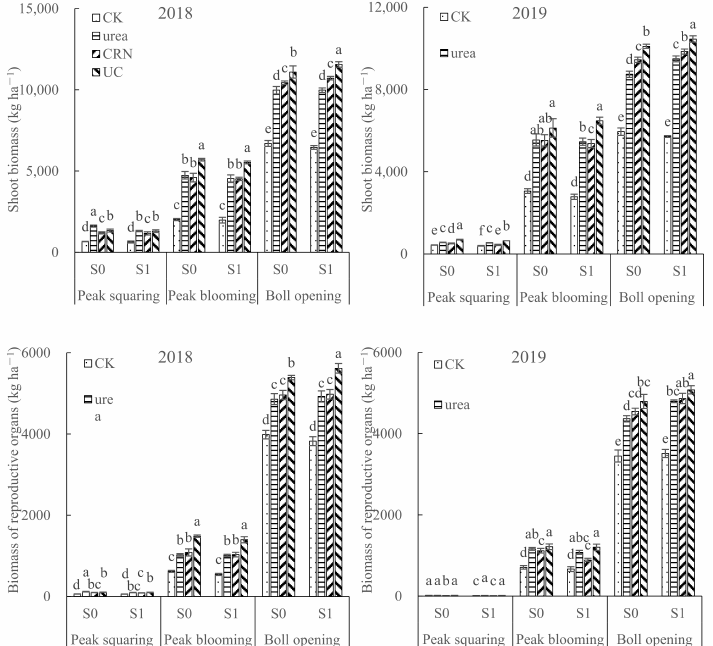
Figure 1. Effects of straw management combined with N-fertilization strategy on biomass accumula- tion at main growth stages in field-seeded cotton. The data are the means for three replications ± SD. Different letters on the bar mean significant difference at the 0.05 level. S0, straw removal; S1, straw returning; CRN, controlled-release N fertilizer; UC, the mixture of urea and CRN.